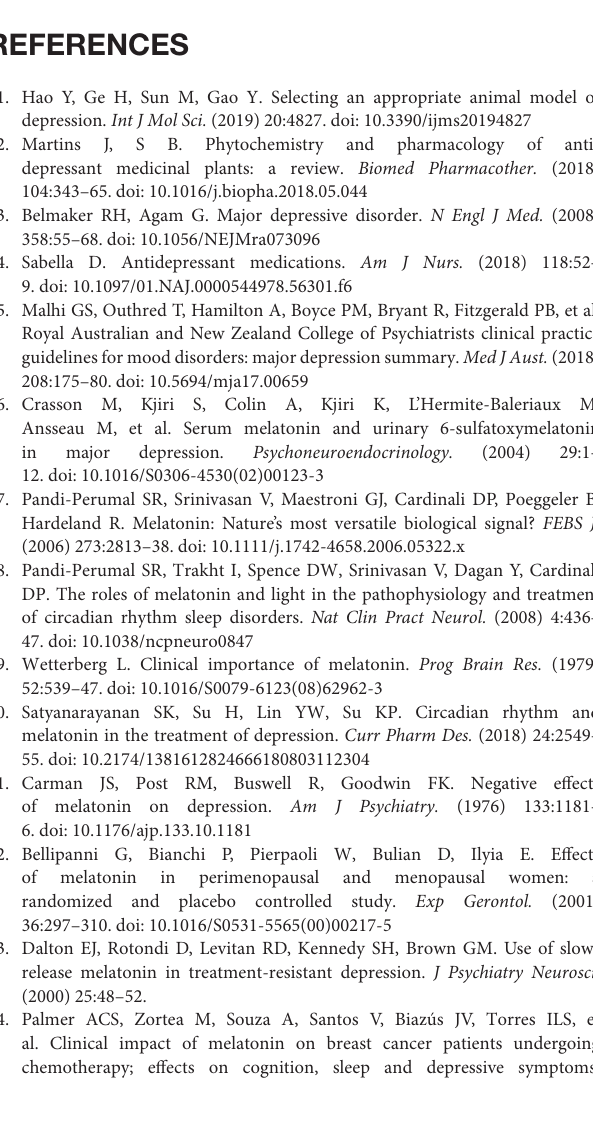
Supplementary Figure S2 | Subgroup analysis on treatment duration. SMD, standardized mean difference; CI, confidence interval. Supplementary Figure S3 | Meta-analysis of effect of melatonin on depression measured by BDI score. (A) Overall meta-analysis; (B) subgroup analysis of Supplementary Figure S7 | Meta-analysis on MDI score. MDI, Major Depression Inventory; SMD, standardized mean difference; CI, confidence interval.